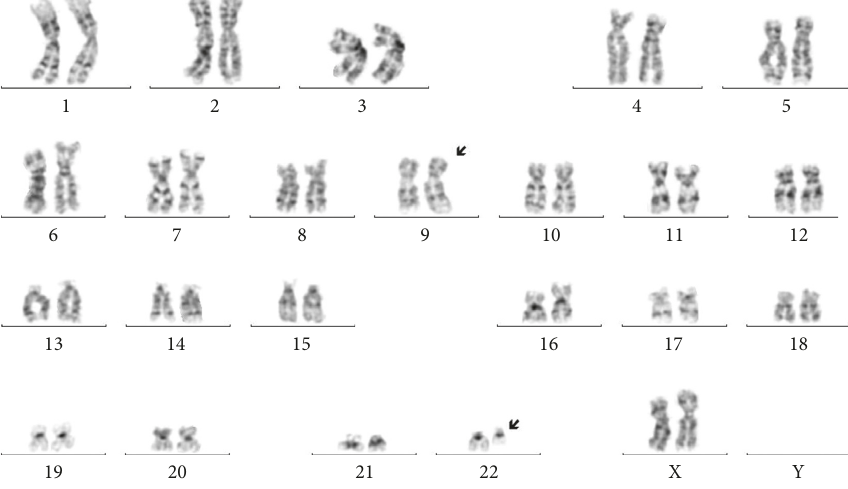
Figure 4: Conventional karyotyping shows positive t (9,